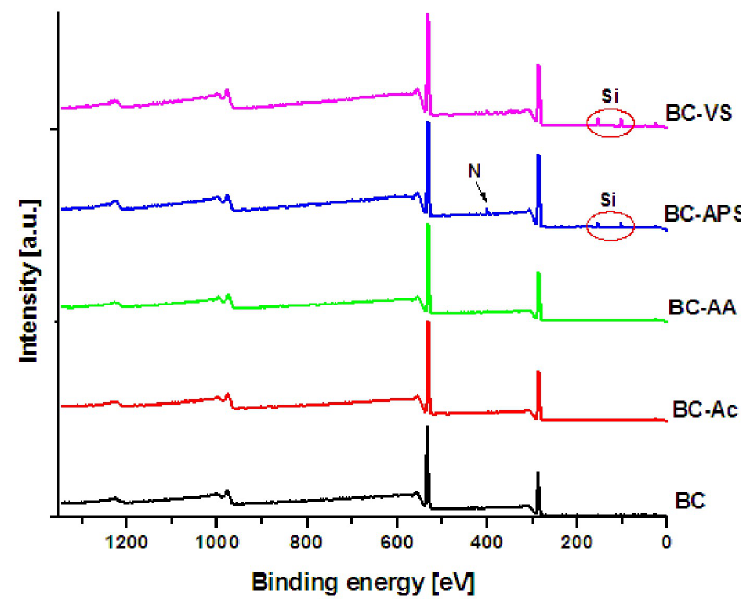
Figure 7. XPS survey spectra of treated BC.